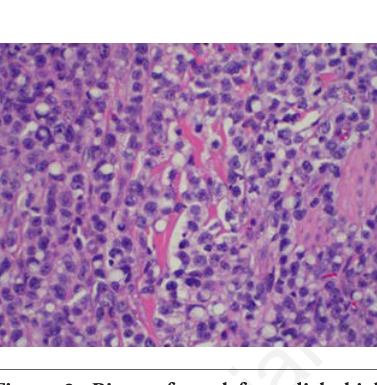
Figure 3. Biopsy from left medial thigh showing signet ring cell morphology.